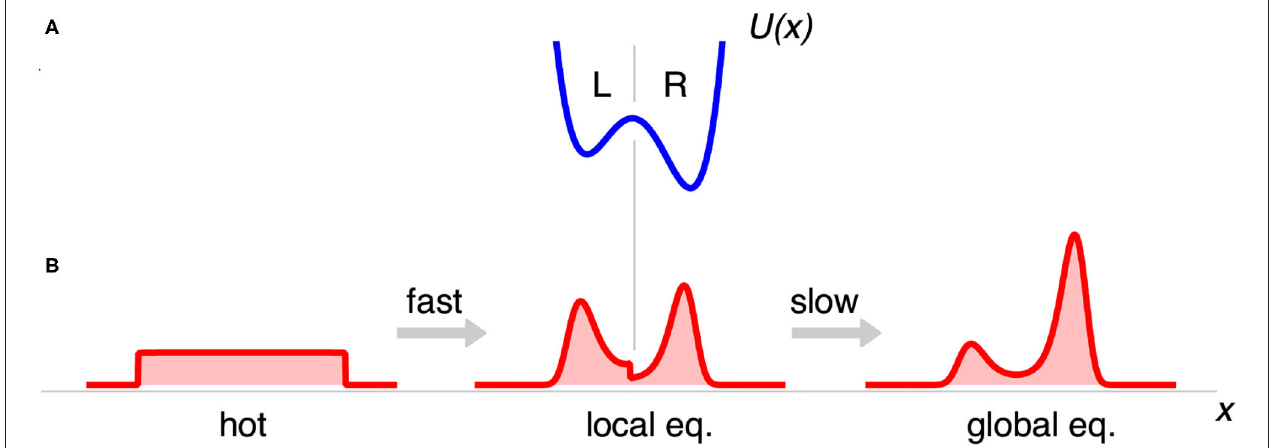
FIGURE 1 | Two-stage dynamics. (A) Tilted double-well potential U ( x ) with coarse-grained states { L , R } . The potential includes a box (not shown). (B) Evolution of the probability density function for position: a high-temperature equilibrium initial state g β ( x ) (left) has a fast relaxation to a local equilibrium state ρ leq β , β slow relaxation to global equilibrium g β ( x ) at the colder bath temperature b